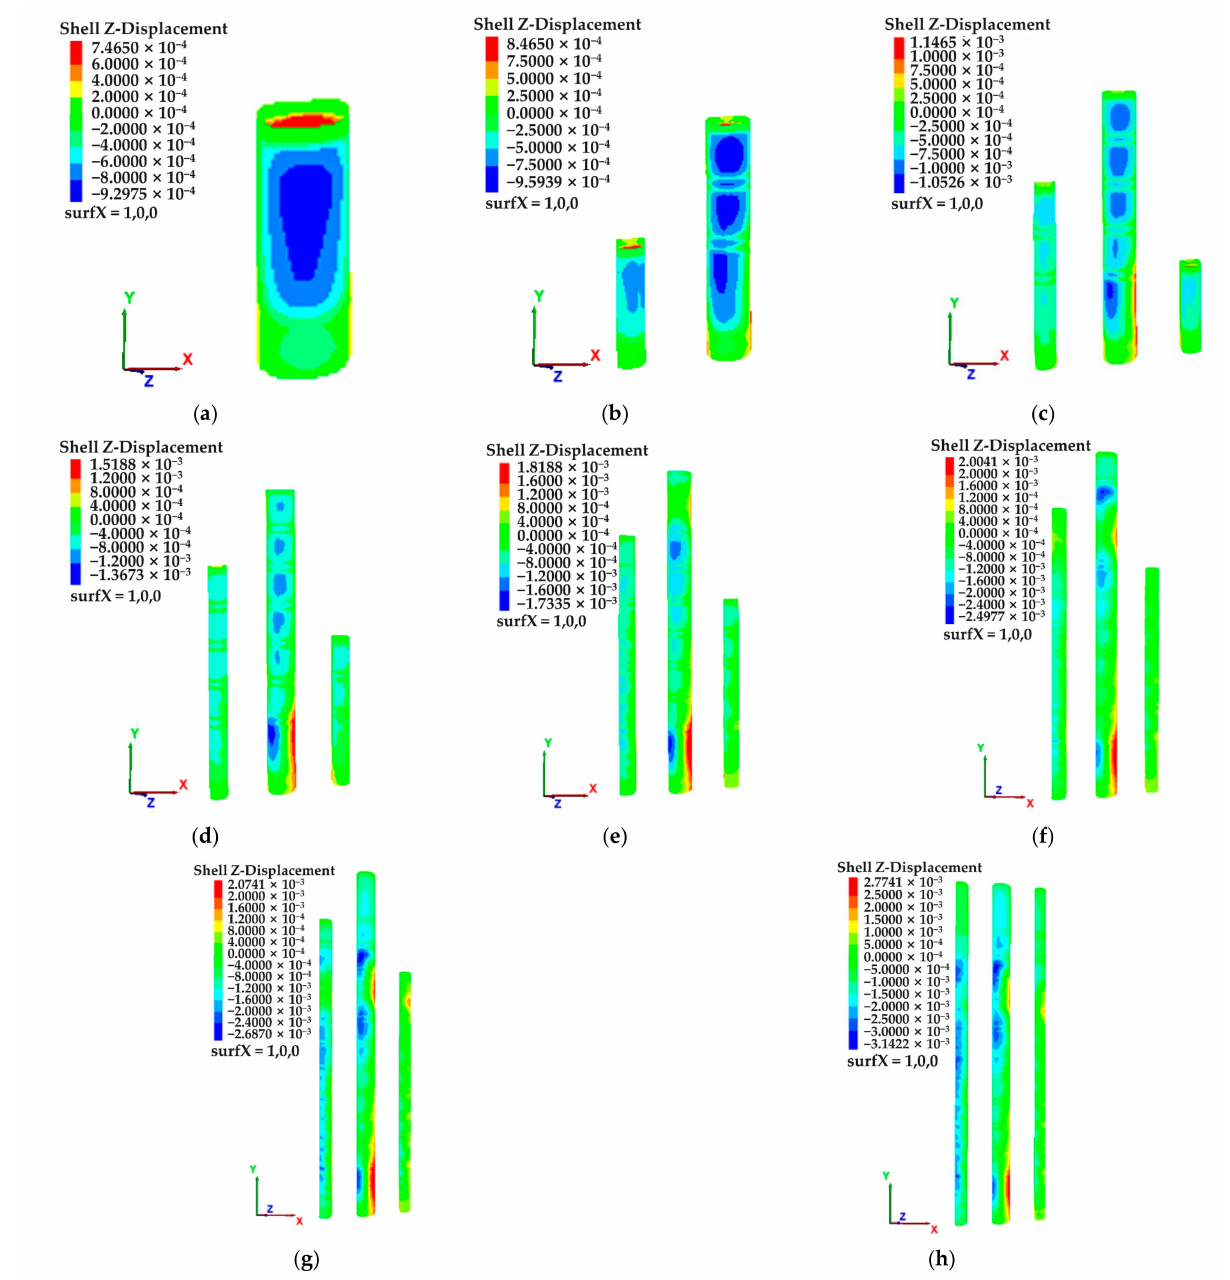
Figure 10. Vertical deformation of lining during pilot tunnel excavation (unit: m): ( a ) L = 20 m; ( b ) L = 40 m; ( c ) L = 60 m; ( d ) L = 80 m; ( e ) L = 100 m; ( f ) L = 120 m; ( g ) L = 140 m; and ( h ) The pilot tunnel excavation is